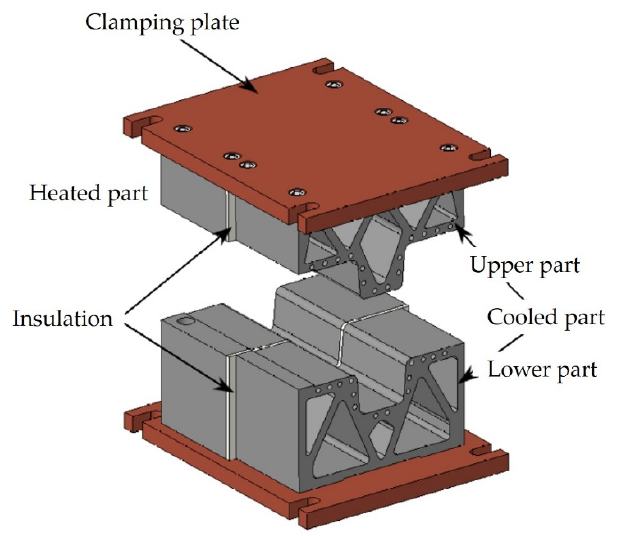
Figure 2. CAD assembly of the combined tool.